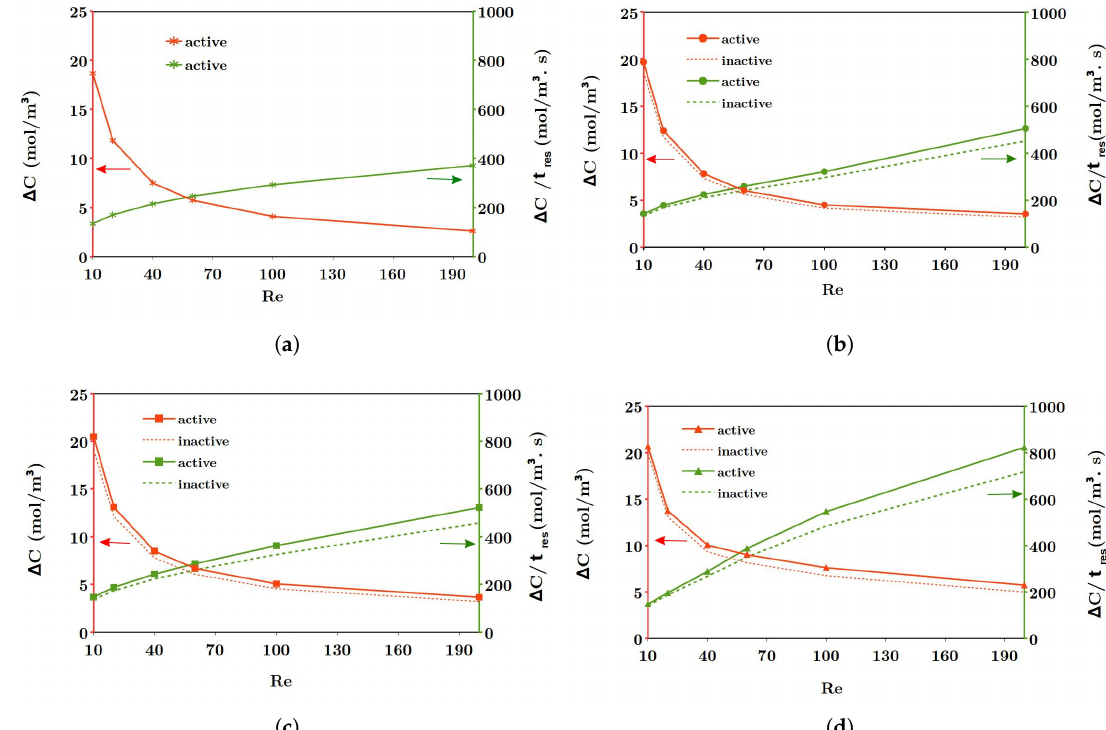
∆ C Corrugation ) and ∆ C flat